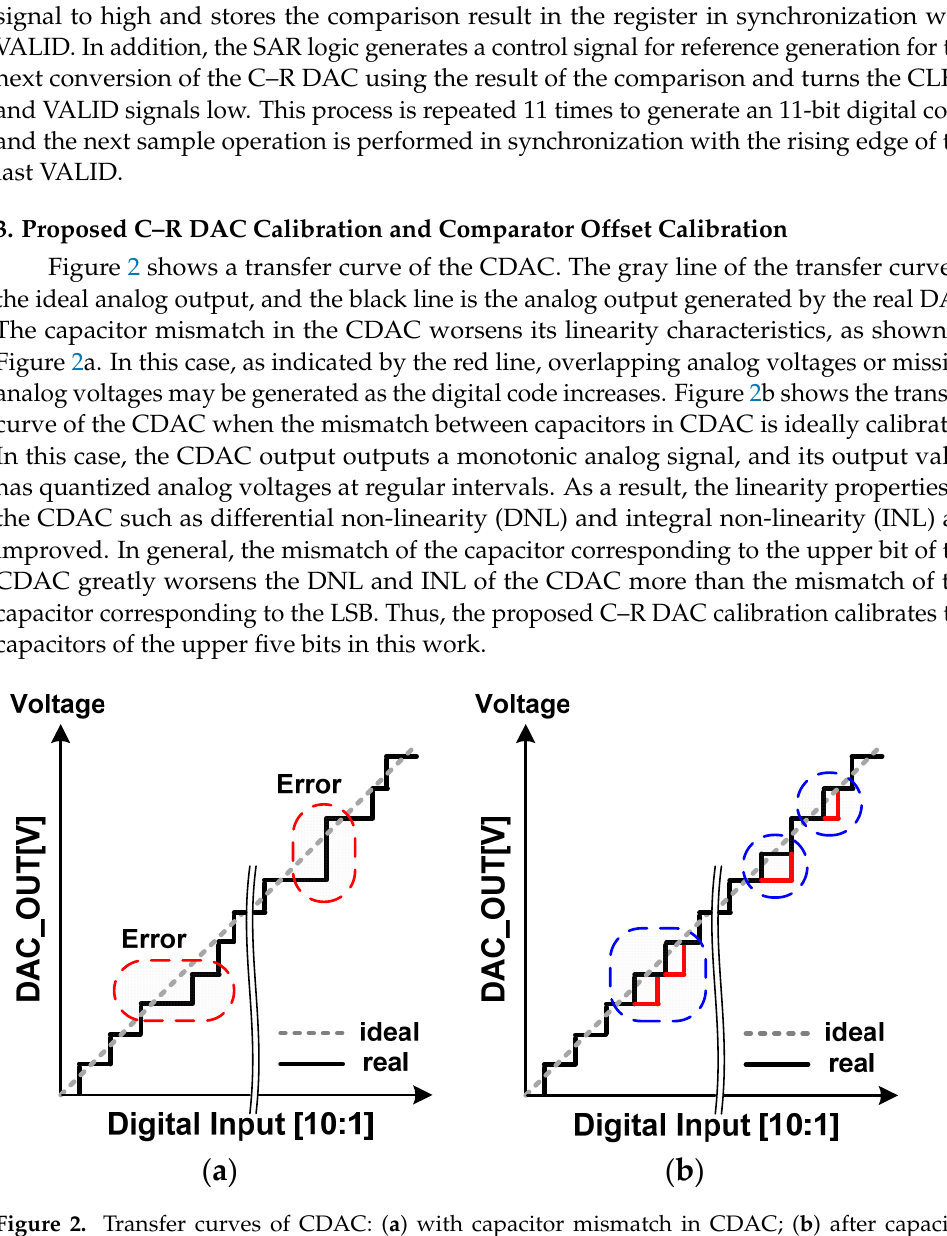
Figure 2. Transfer curves of CDAC: ( a ) with capacitor mismatch in CDAC; ( b ) after capacitor calibration in CDAC.